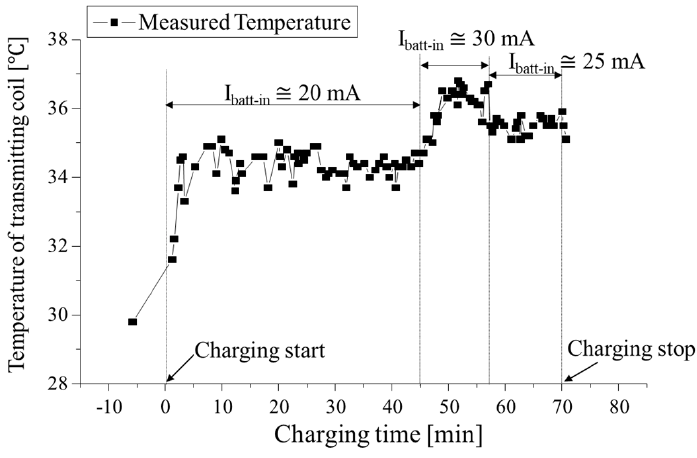
Figure 19. Temperature captured by image sensor for 70 min.